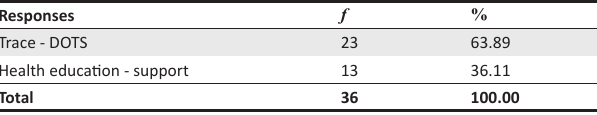
TABLE 6: Respondents’ views on how they handle adherence and abstinence by patients ( n = 36).